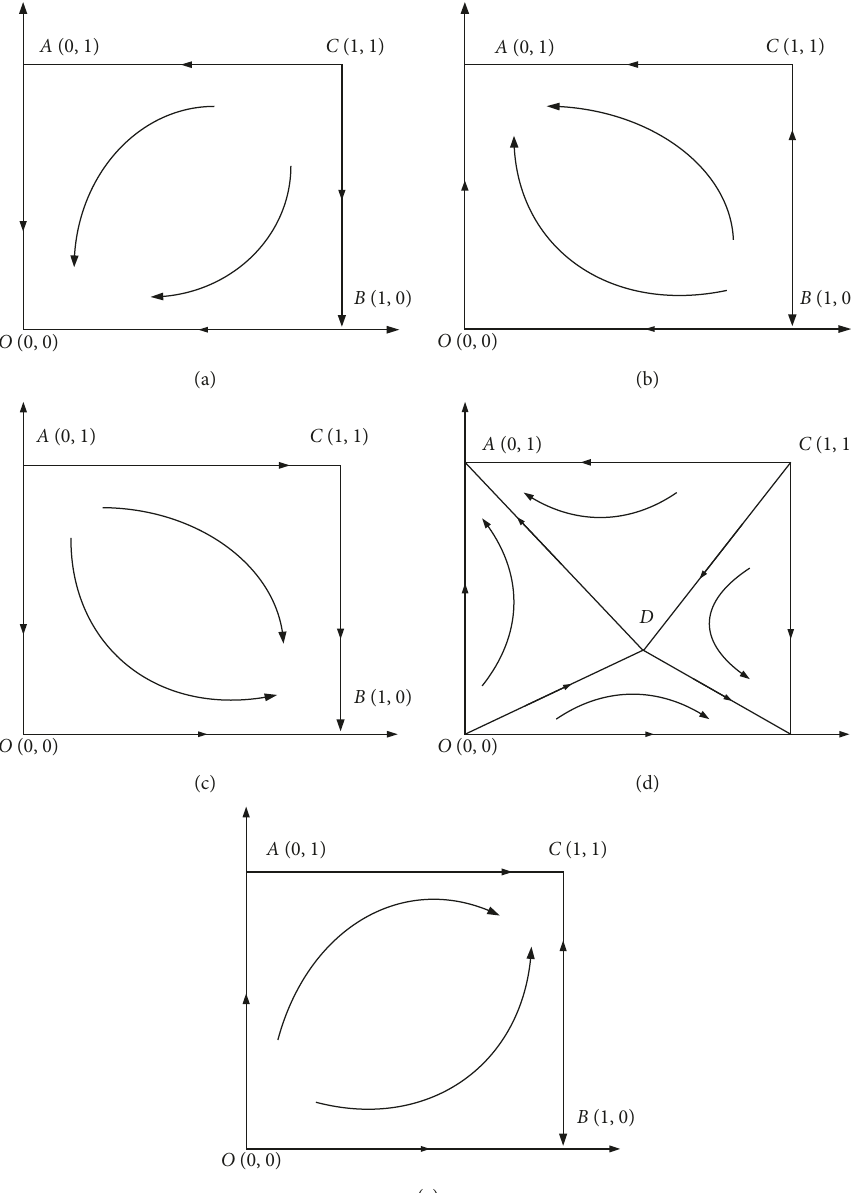
Figure 1: Phase diagrams of the evolutionary game.